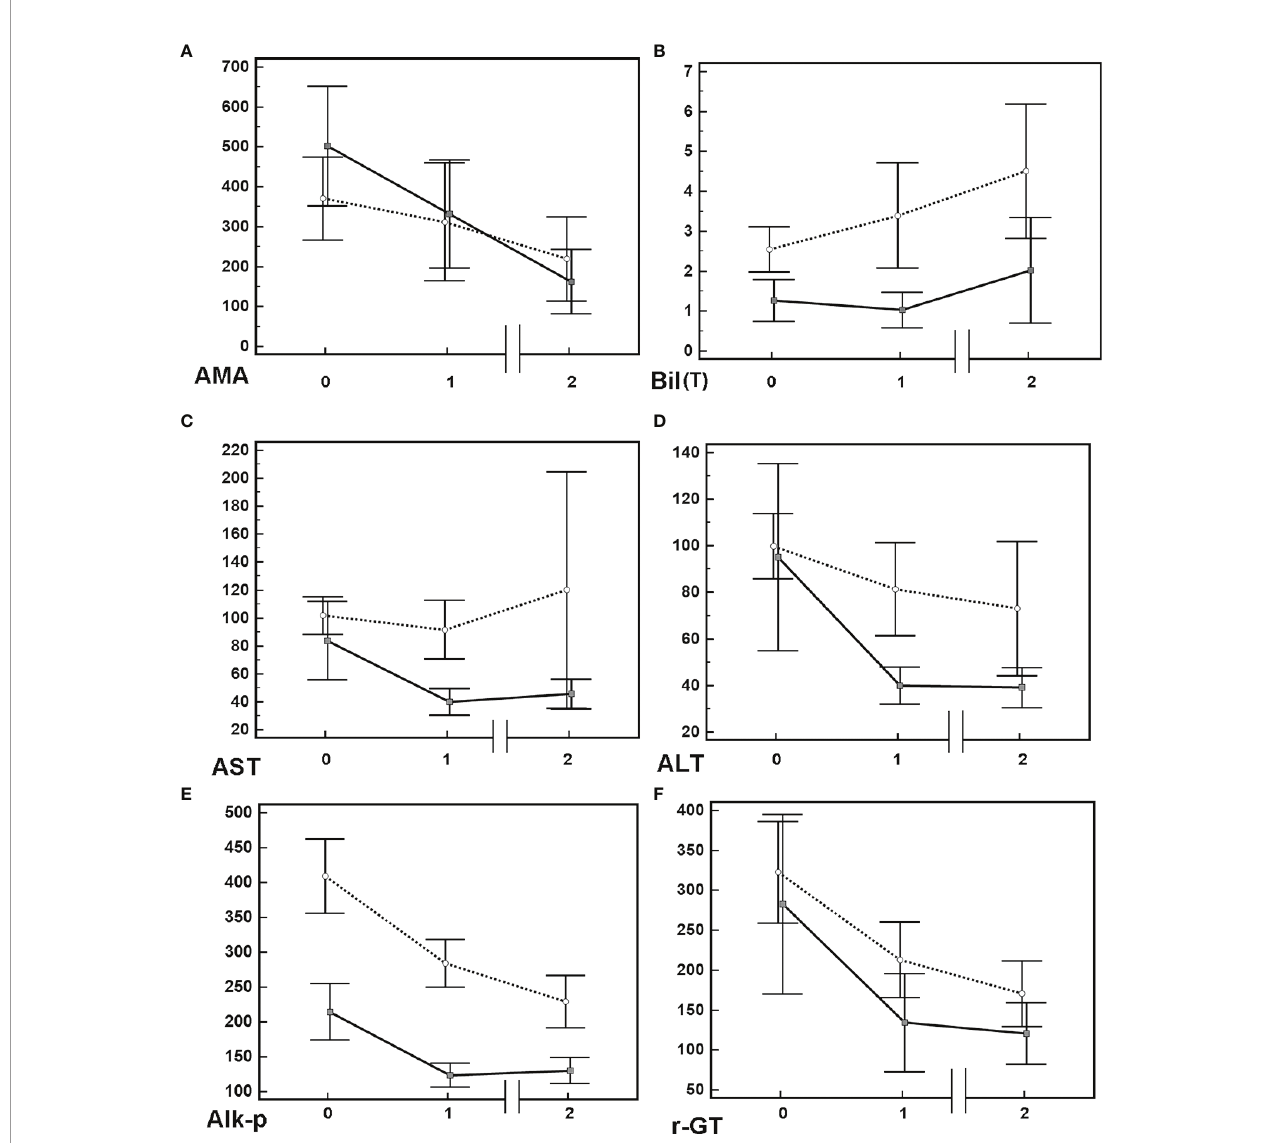
FIGURE 1 | Mean+/-95% con fi dence interval of various biochemistry levels in PBC patients. (A) Anti-mitochondrial Ab [AMA, titrated titers (indirect immuno fl uorescence assays)], (B) total bilirubin [Bil (T) (mg/dL)]. (C) aspartate aminotransferase [AST(U/L)]. (D) alanine aminotransferase [ALT(U/L)]. (E) alkaline phosphatase [Alk-p (U/L)]. (F) g -glutamyltransferase [-GT (U/L)]. Solid lines: data of patients with UDCA response; dashed lines: data of patients without UDCA response. Time 0: baseline; Time 1: 1 year after usage of UDCA; Time 2: fi nal follow-up after usage of UDCA.